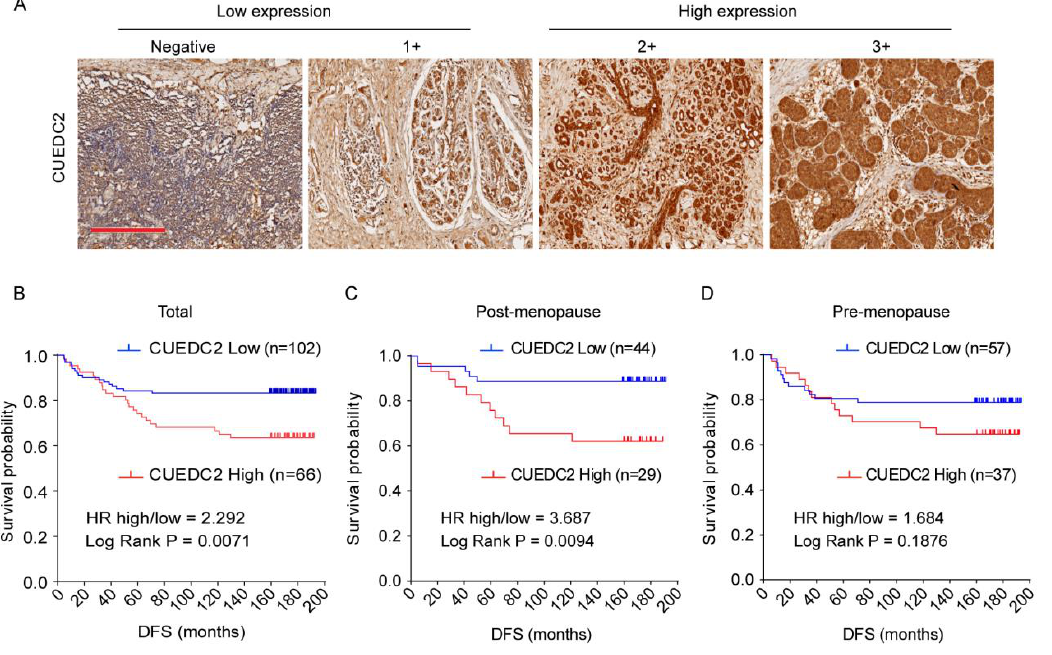
Figure 1. Expression of CUEDC2 in tumor tissues of TNBC. ( A ) IHC detection of CUEDC2 expression in tumor tissues, bar = 300 μm. ( B – D ). Kaplan-Meier (K-M) survival analysis on the disease-free survival (DFS) of the total ( B ), post-menopause ( C ), and pre-menopause ( D ) patients with different levels of CUEDC2 expression in tumor tissues.